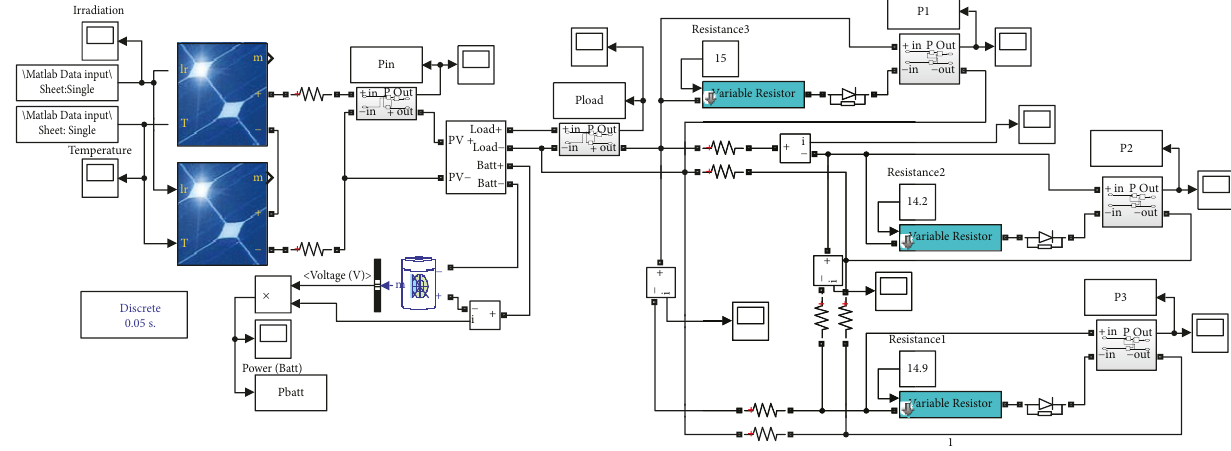
Figure 5: MATLAB Simulink model of the single-source con fi